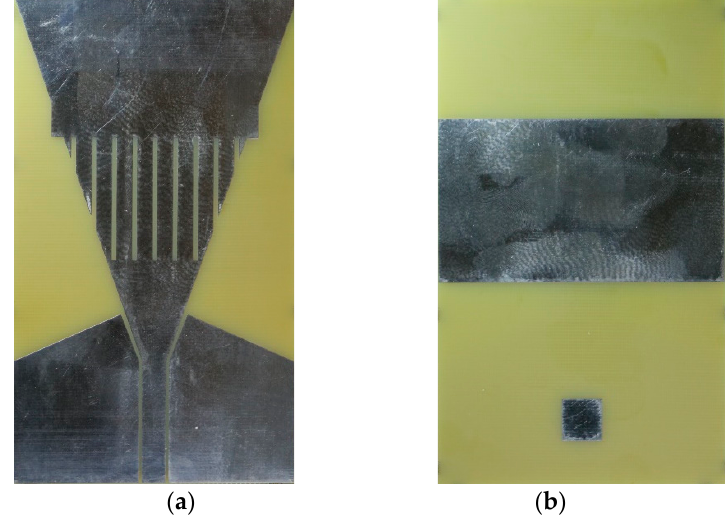
Figure 3. Picture of fabricated braided antenna ( a ) front ( b ) back.